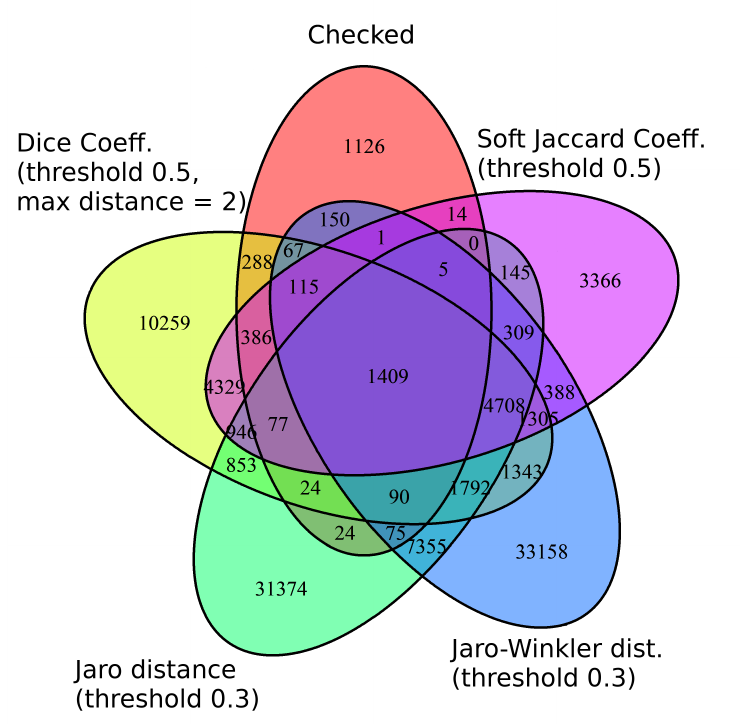
Figure 10. Venn diagram of top four methods, regarding Recall